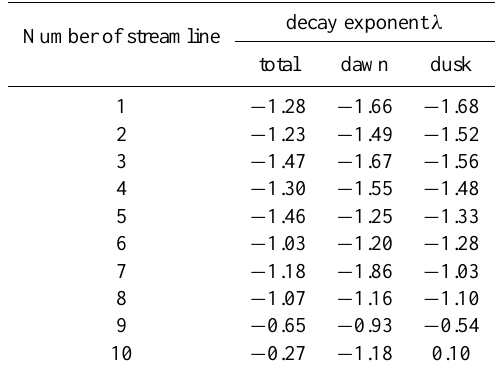
Table 1. Decay exponents of the wave intensity in the magne- tosheath derived from Fig. 2 (total) as well as for the dawn and dusk side of the magnetosheath derived from Fig.